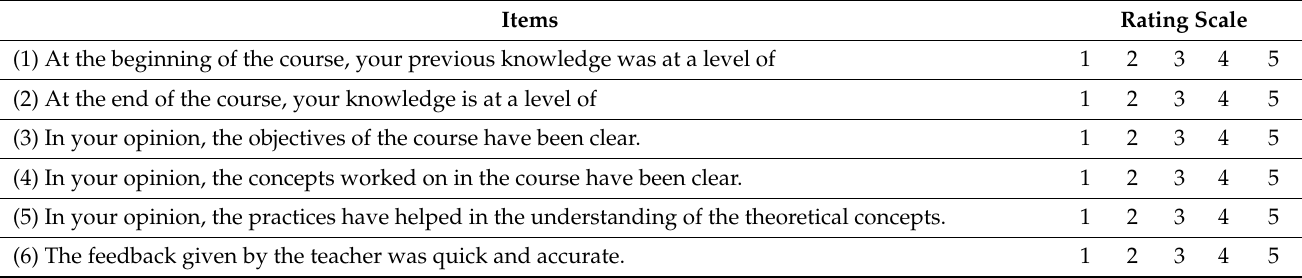
Table A2. Questionnaire of General Satisfaction with the Training Activity [47].